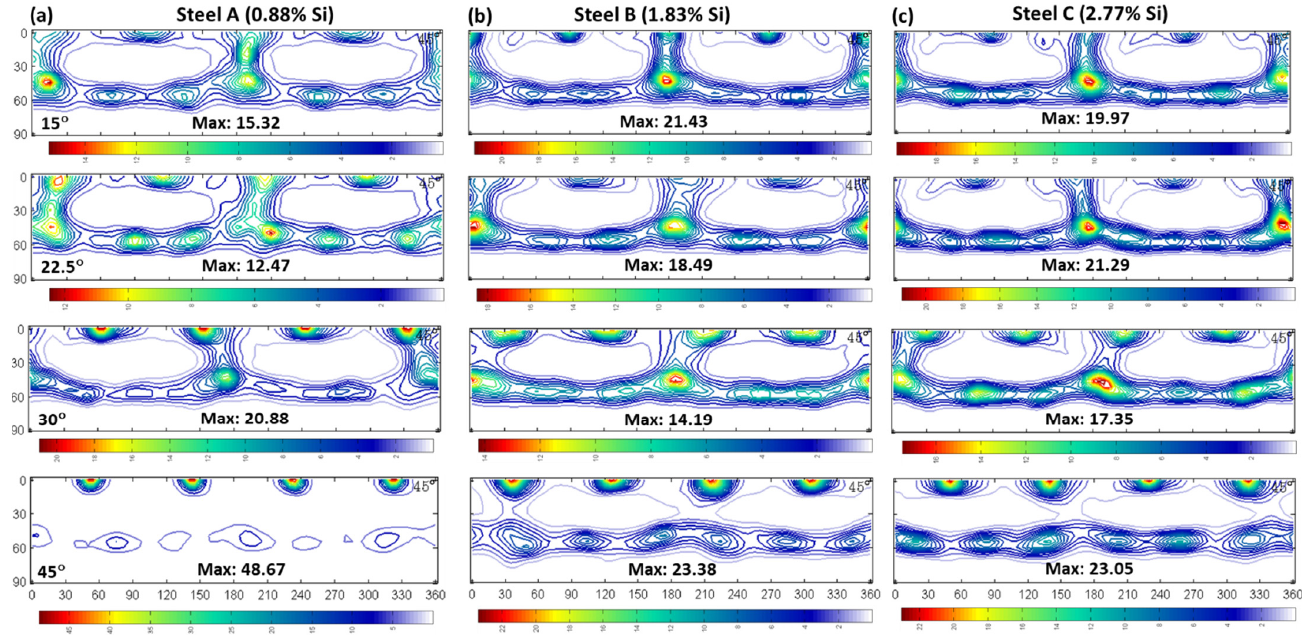
Figure 6. Textures after skew cold rolling with bidirectional feeding [26]: ( a ) Steel A, ( b ) Steel B and ( c ) Steel C.